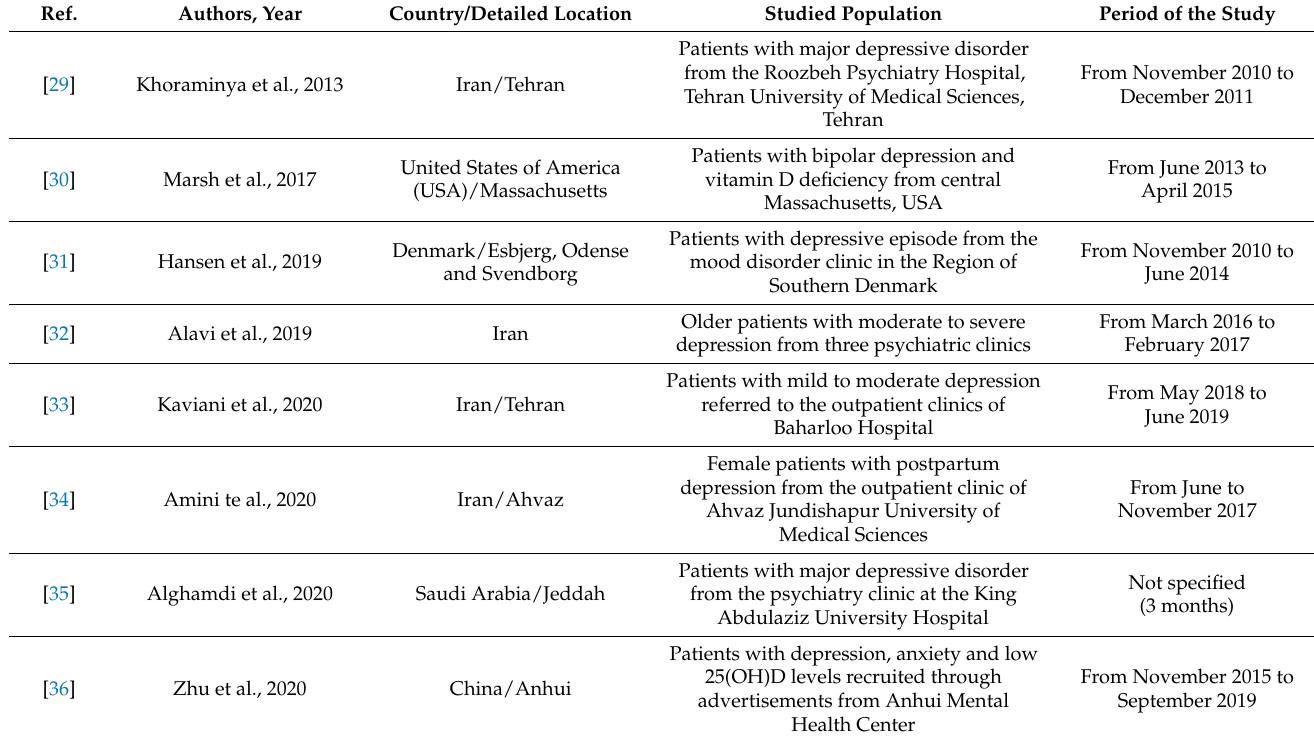
Table 2. The general descriptions of the studies and studied populations within studies included to a systematic